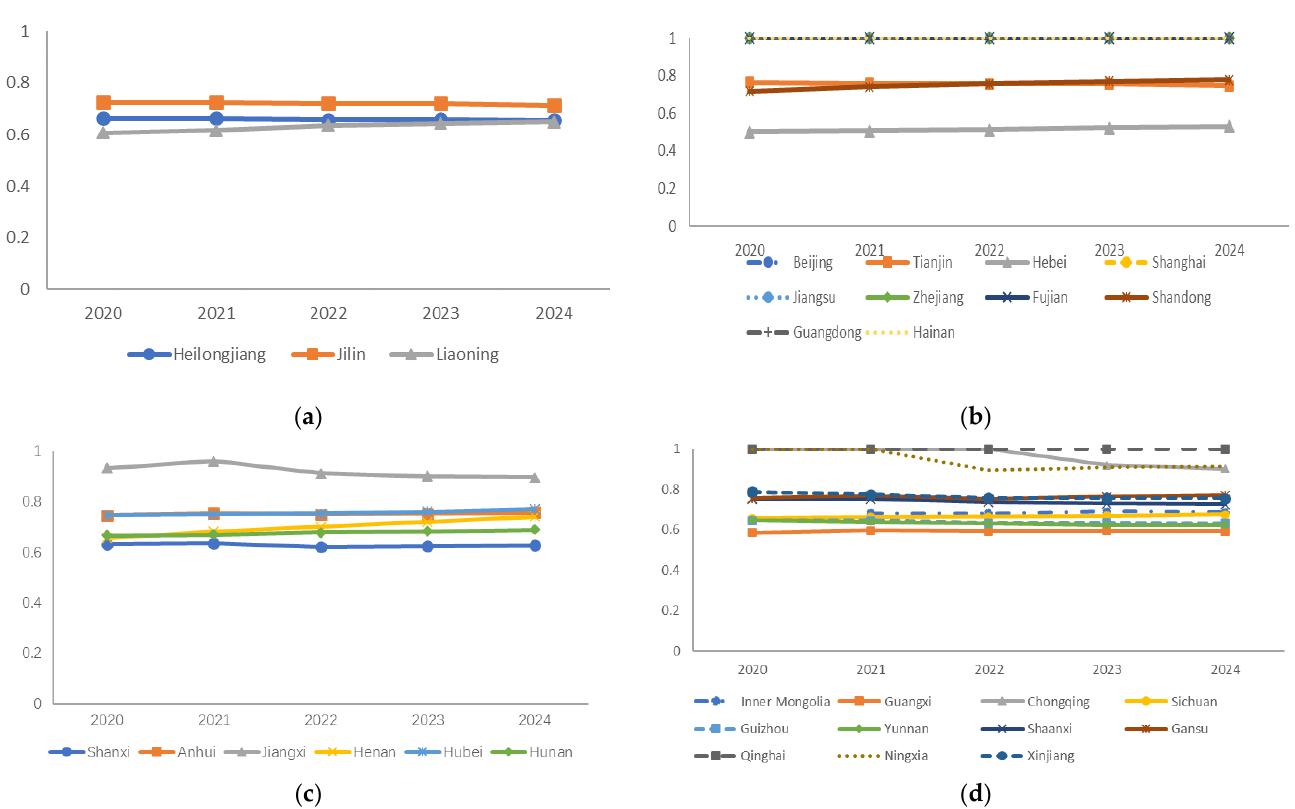
Figure 7. ( a ) Projected results of carbon emission efficiency in Northeastern China in the next five years; ( b ) projected results of carbon emission efficiency in Eastern China in the next five years; ( c ) projected results of carbon emission efficiency in Central China in the next five years; ( d ) projected results of carbon emission efficiency in Western China in the next five years.